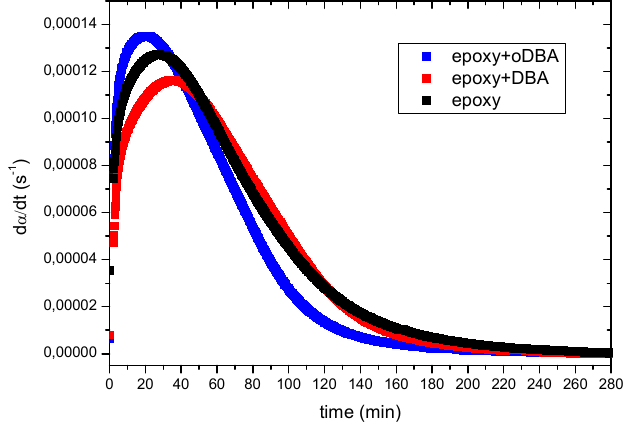
Figure 5. The d α / dt curves calculated from the DSC data shown in Figure 4 using Equation (1) Figure 5. The dα/dt curves calculated from the DSC data shown in Figure 4 using Equation (1) (Section (Section 2.4.5). 2.4.5).